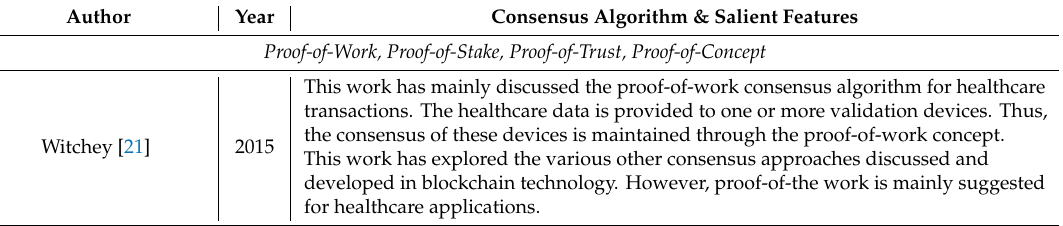
Table 1. Comparative state-of-the-art survey of consensus algorithms in various blockchain-based healthcare